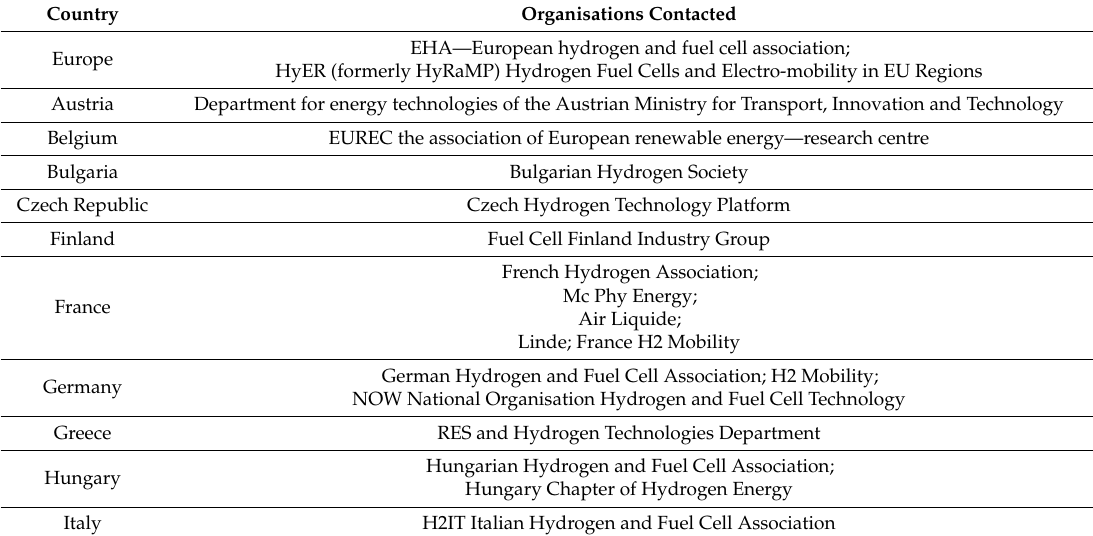
Figure 2. European countries involved in the survey. Table 1. Organizations involved in the survey for each European country.